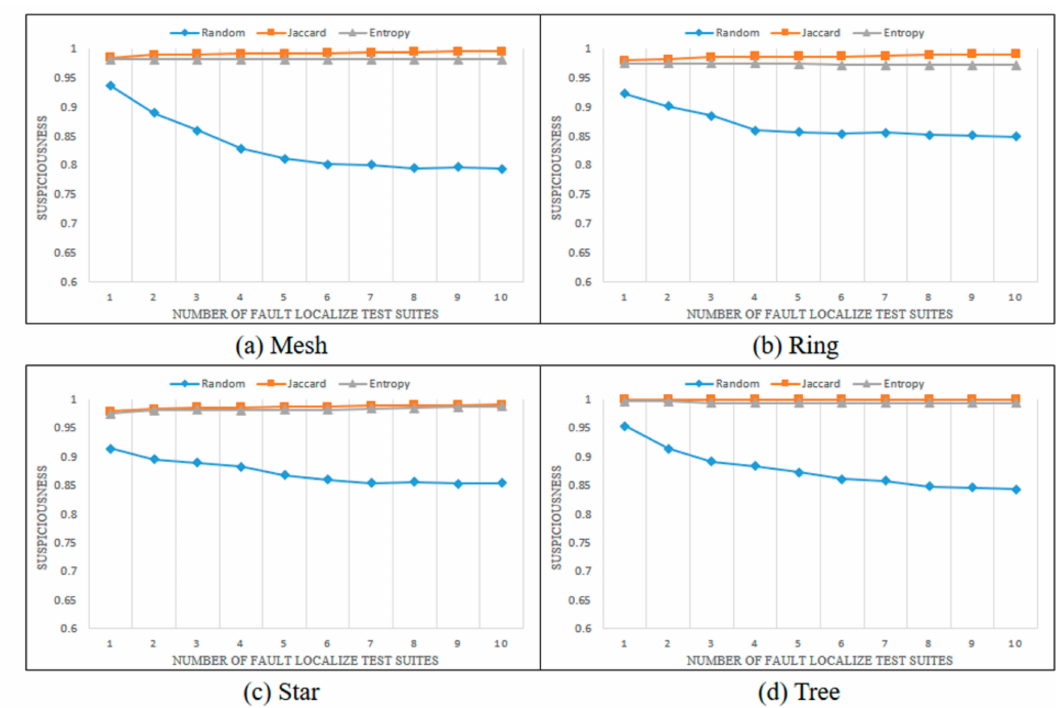
Figure 7. Average suspiciousness of faulty statements (weak case).